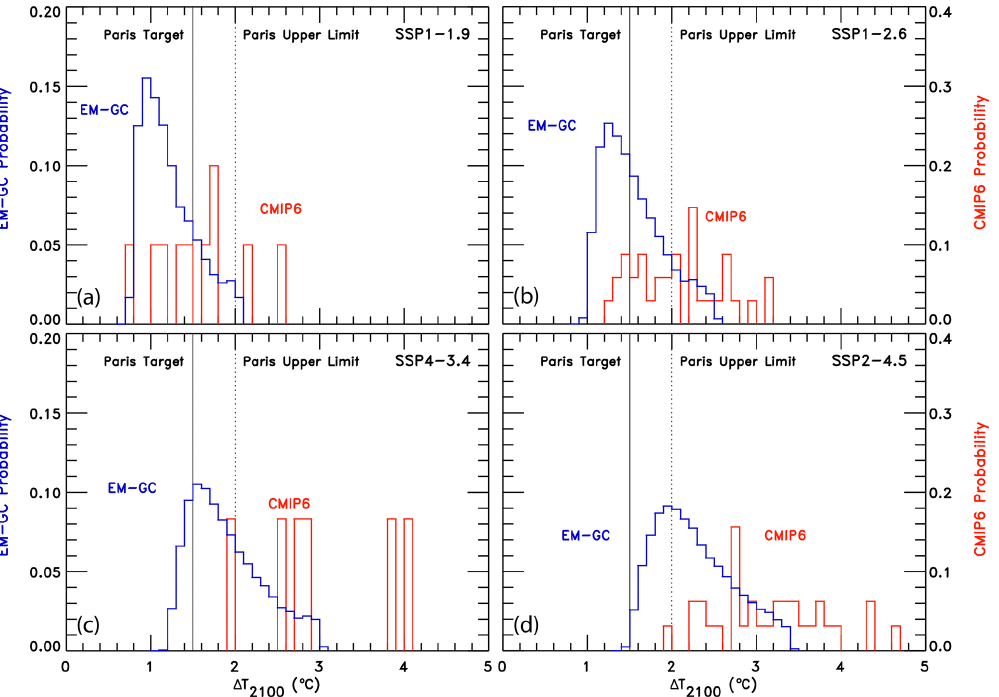
Figure 12. Probability density functions (PDFs) for (cid:49)T 2100 found using the EM-GC trained with the HadCRUT5 temperature record (dark blue) and CMIP6 multi-model results (red). (a) PDF for EM-GC results and CMIP6 multi-model results for SSP1-1.9. The left-hand y axis is for EM-GC probabilities, and the right-hand y axis is for the CMIP6 multi-model ensemble probabilities. (b) PDF for SSP1-2.6. (c) PDF for SSP4-3.4. (d) PDF for